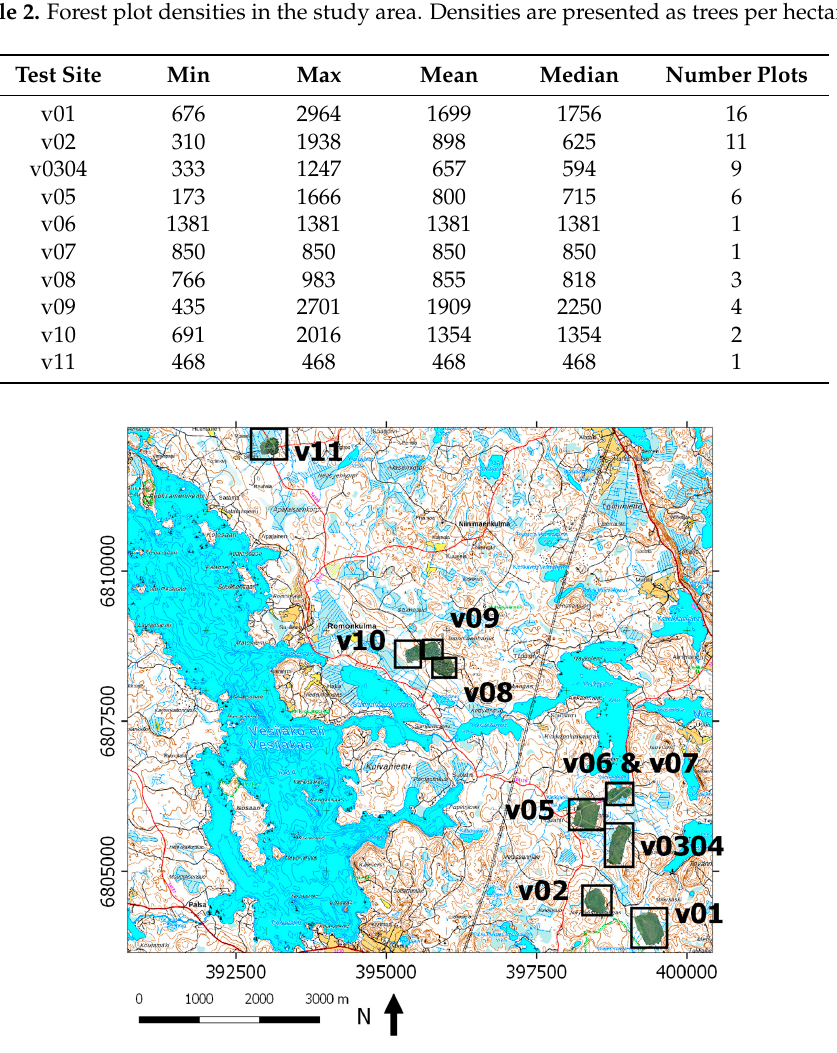
Figure 1. The geographical locations of the study areas. The area is located in the Vesijako research forest area in the municipality of Padasjoki in southern Finland (approximately 61°24 ′ N and 25°02 ′ E).